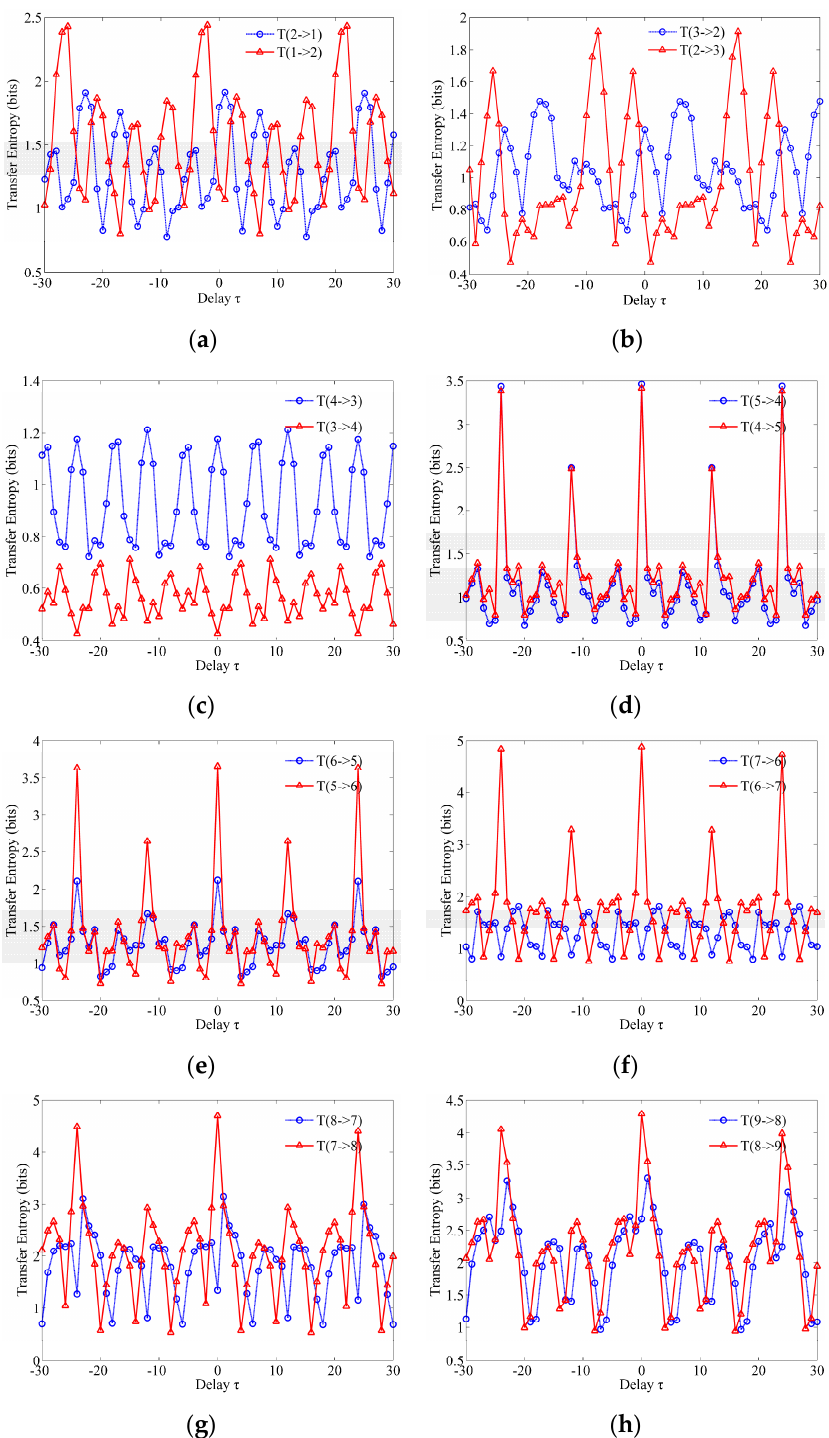
Figure 12. Time-delayed transfer entropy curve of the original fluid pressure pulsation. Transfer entropy between measuring points F01 and F02 ( a ), F02 and F03 ( b ), F03 and F04 ( c ), F04 and F05 ( d ), F05 and F06 ( e ), F06 and F07 ( f ), F07 and F08 ( g ), and F08 and F09 ( h ).